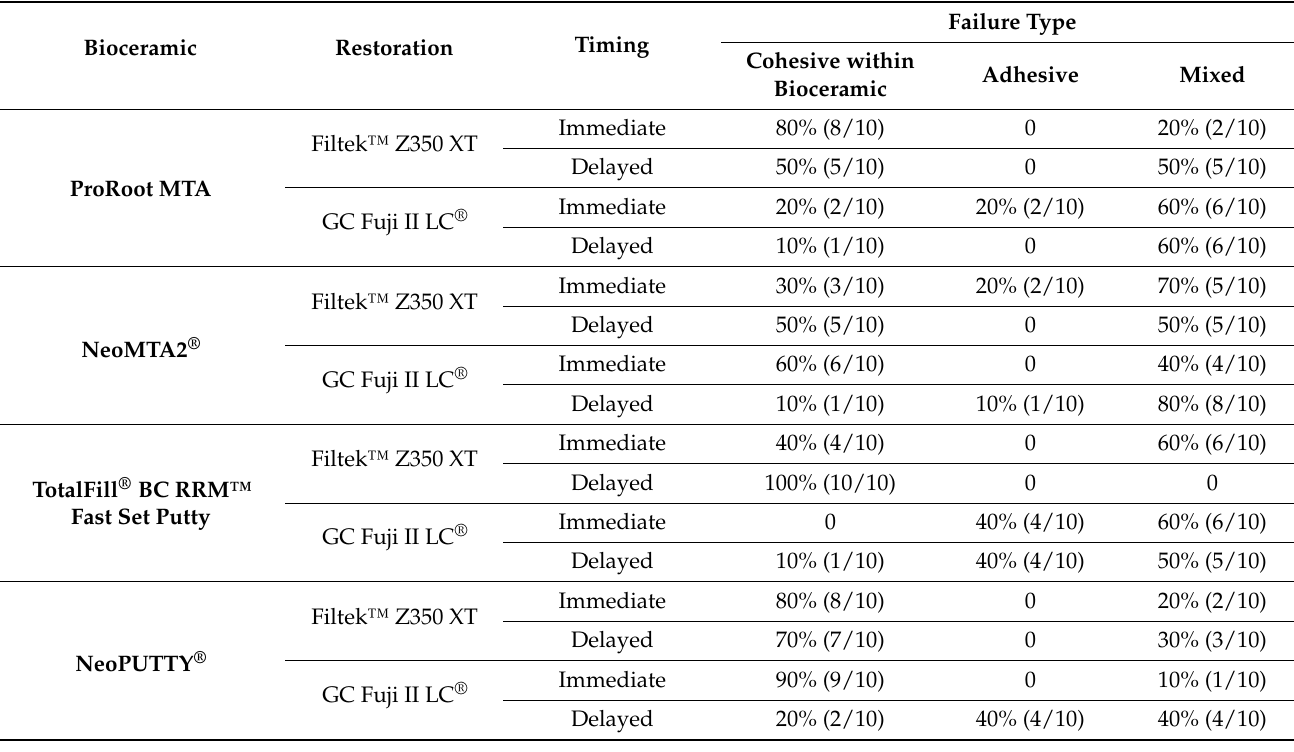
Table 5 . Fracture mode of the groups after shear bond strength testing.